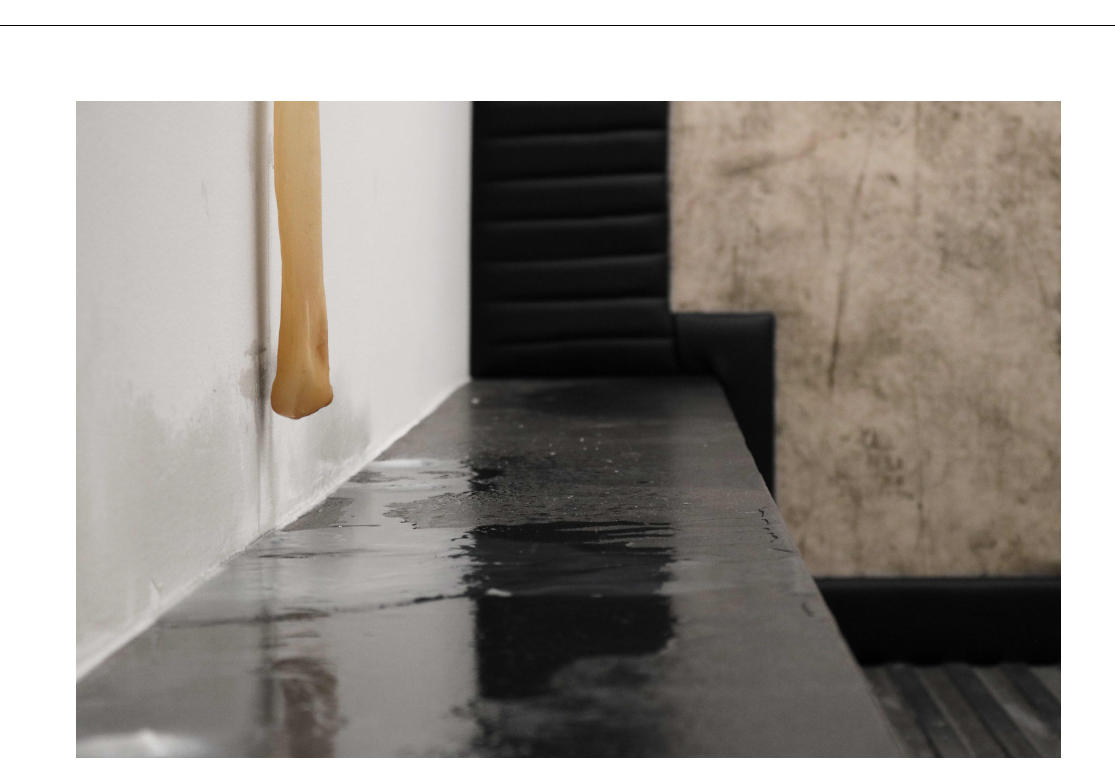
Figure 10: Detail of paraffin wax melting in Oil rituals for the future #6 . Photo: Andy Bennett and Colleen Hargaden. Reproduced with